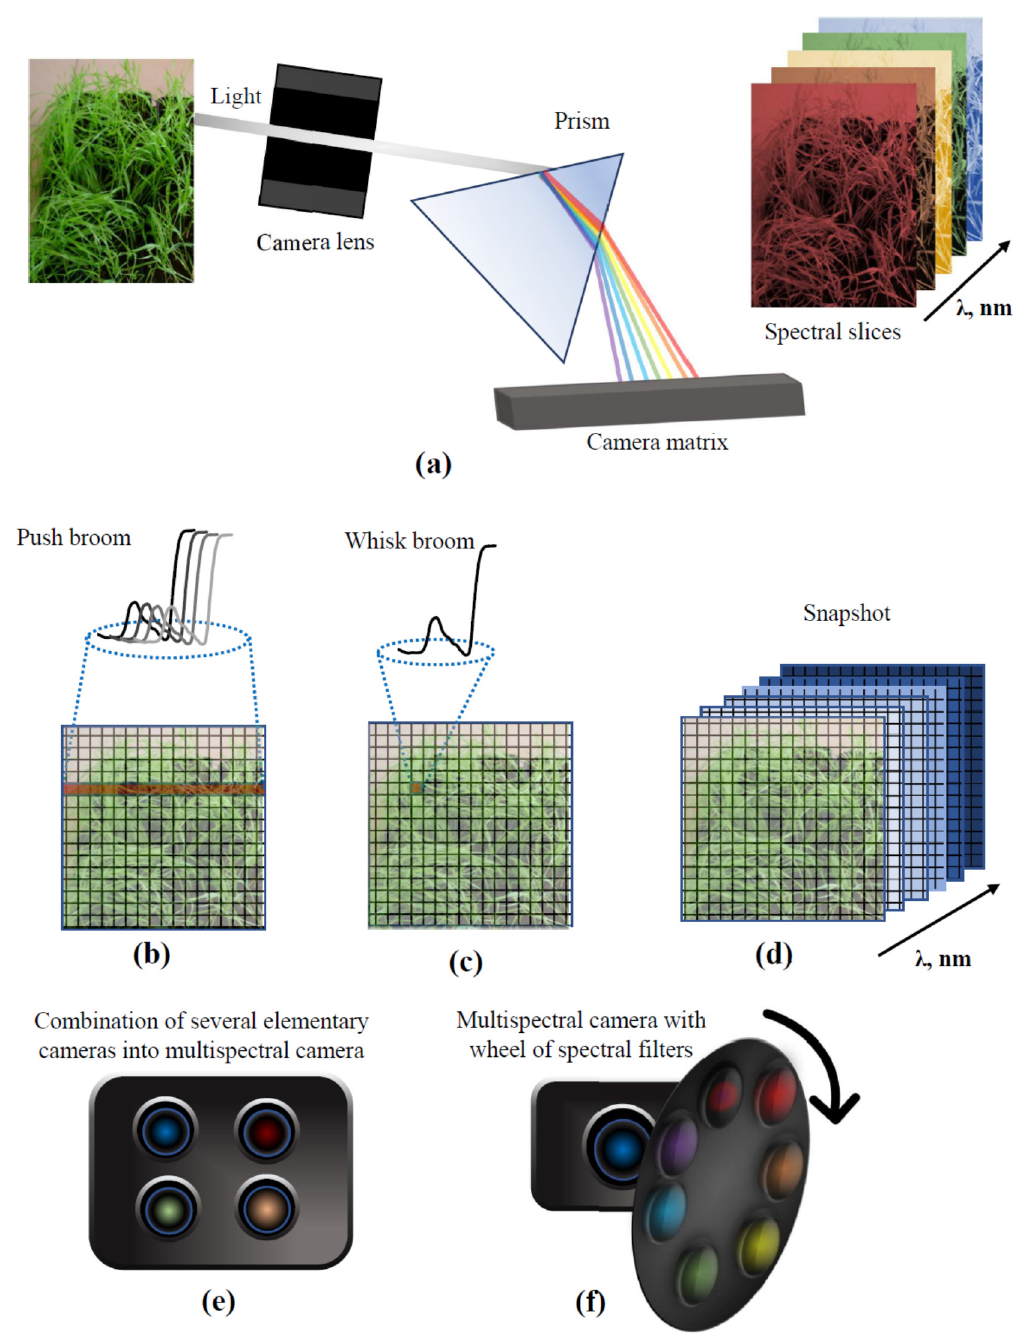
Figure 3. Some variants of hyper- and multispectral cameras. ( a ) The simple schema of the hyperspectral camera with line-by-line scanning. ( b ) The schema of the line-by-line scanning (push broom). ( c ) The schema of the point-by-point scanning (whisk broom). ( d ) The schema of scanning of the whole hypercube (snapshot). ( e ) Multispectral camera with several elementary cameras equipped by narrow band spectral filters. ( f ) Multispectral camera with single camera and wheel of narrow band spectral filters.